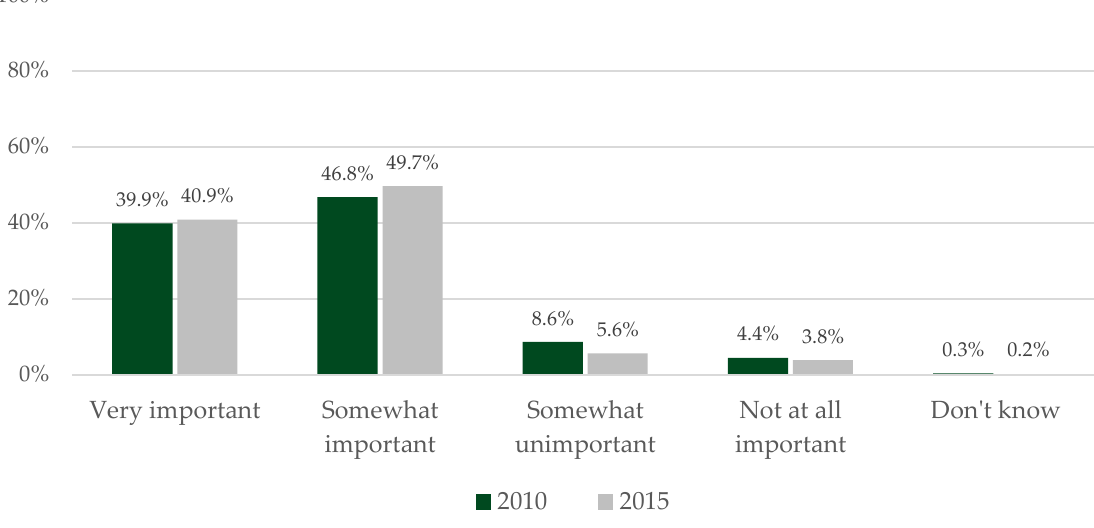
Figure 1. Evolution between 2010 and 2015 of the perceived importance of the role of diet in cancer risk ( p < 0.001).